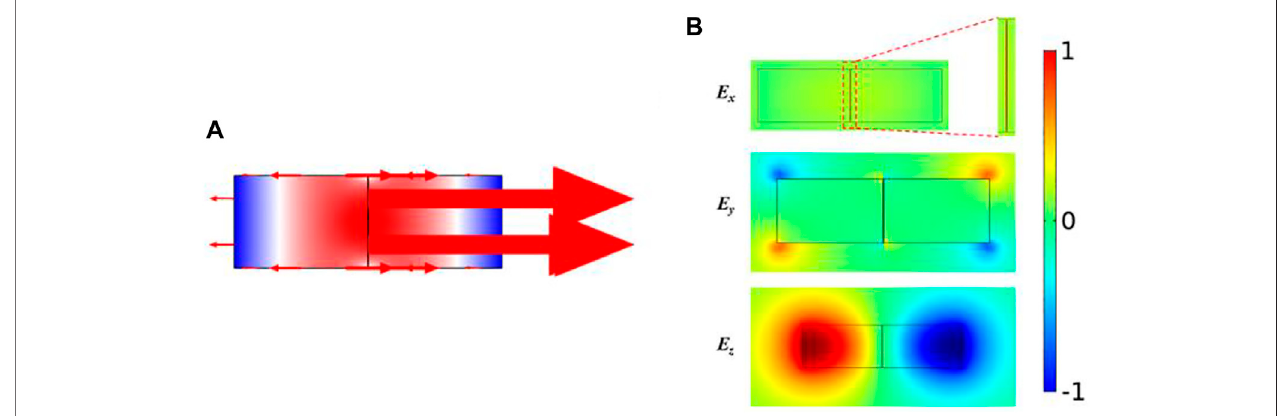
FIGURE 2 | Data obtained showing the radiation pressure distribution of the designed waveguide in the case of an acoustic mode m = 0. (A) Schematic diagram showing the radiation pressure distribution of the slot waveguide. (B) The guiding lateral pro fi le of the fundamental optical mode highlighting the E x , E y and E z fi eld